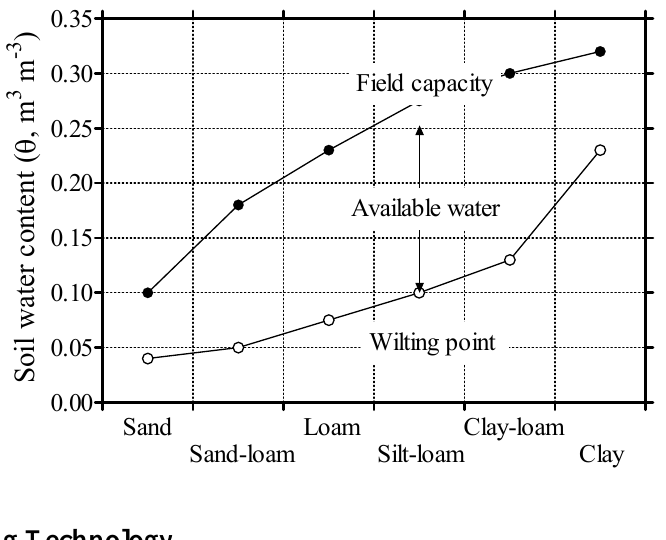
) and at wilting point (  FC and  ) in different types of FC WP